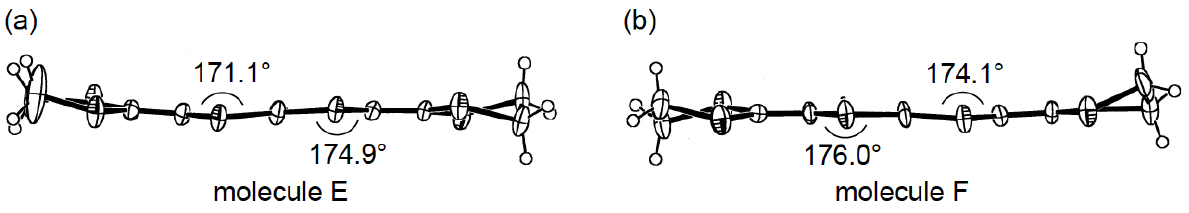
Figure 23. Structures of two independent BDH-TTP molecules ( a ) E and ( b ) F in α-(BDH-TTP) Au(CN) 2 2